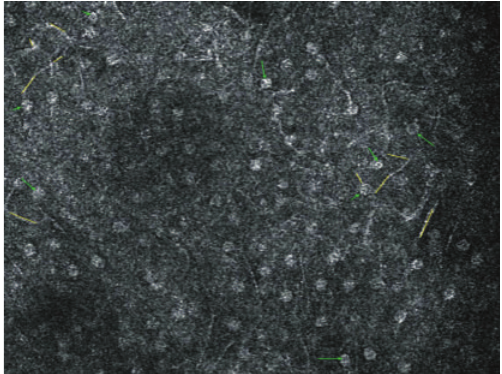
Figure 7: Reflectance confocal microscopy image at the prickle cell layer (Z2). Green arrows: signal bright rounded nuclei. Yellow lines: cytoplasmic border and intercellular